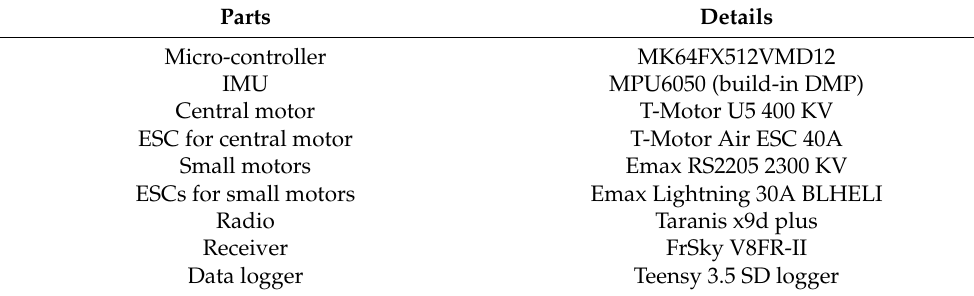
Table 2. Parts used in UAS design.